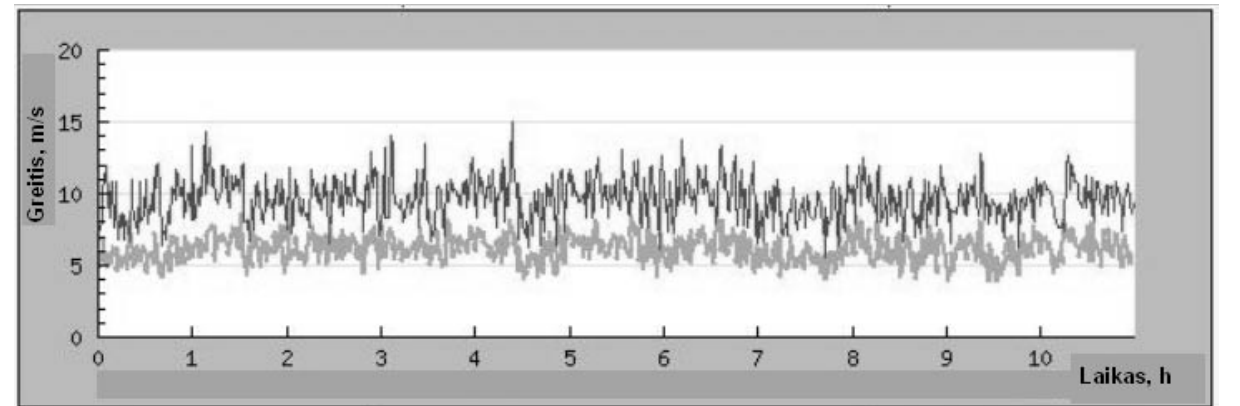
Fig 7 . Chart of water level change (2005-12-01 0–7 h)